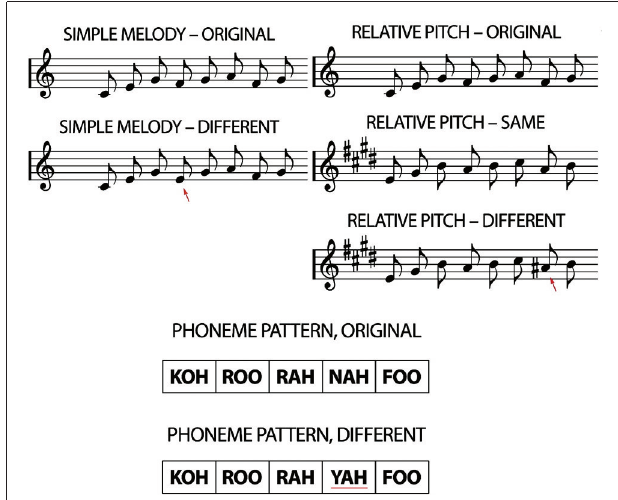
FIGURE 1 | Examples of the transposed melody task (relative pitch) . The “original” played first, followed either by the “same” or “different”, where the red arrow indicates the alteration. The phoneme pattern “original” was either followed by the “original” again, or by the different. Again, the red underline marks the alteration (adapted from Foster and Zatorre,